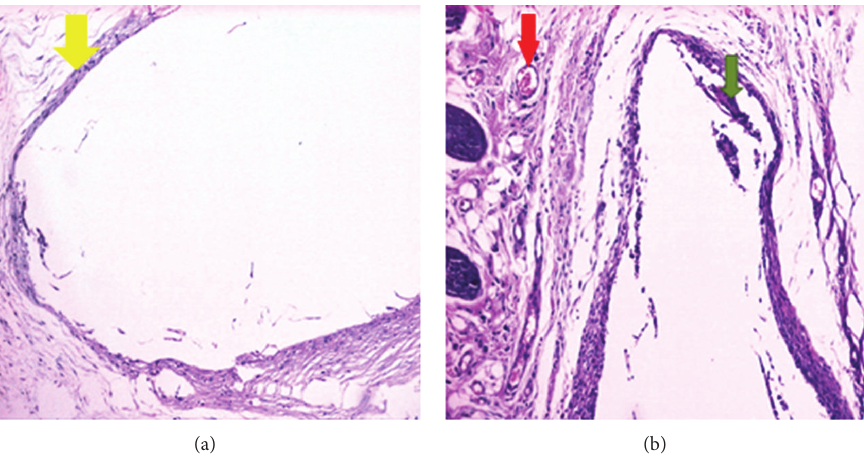
Figure 8: Photographs of sites 15 days after implantation of PLDLA/PCL-T membranes. (a) Site implanted with the 100/0 blend showing the formation of a capsule delimited by dense collagen (yellow arrow), (b) site implanted with the 90/10 blend showing individualized capsules and the presence of giant cells (green arrow) and blood vessels (red arrow). Staining: HE. Magnification: 100x.